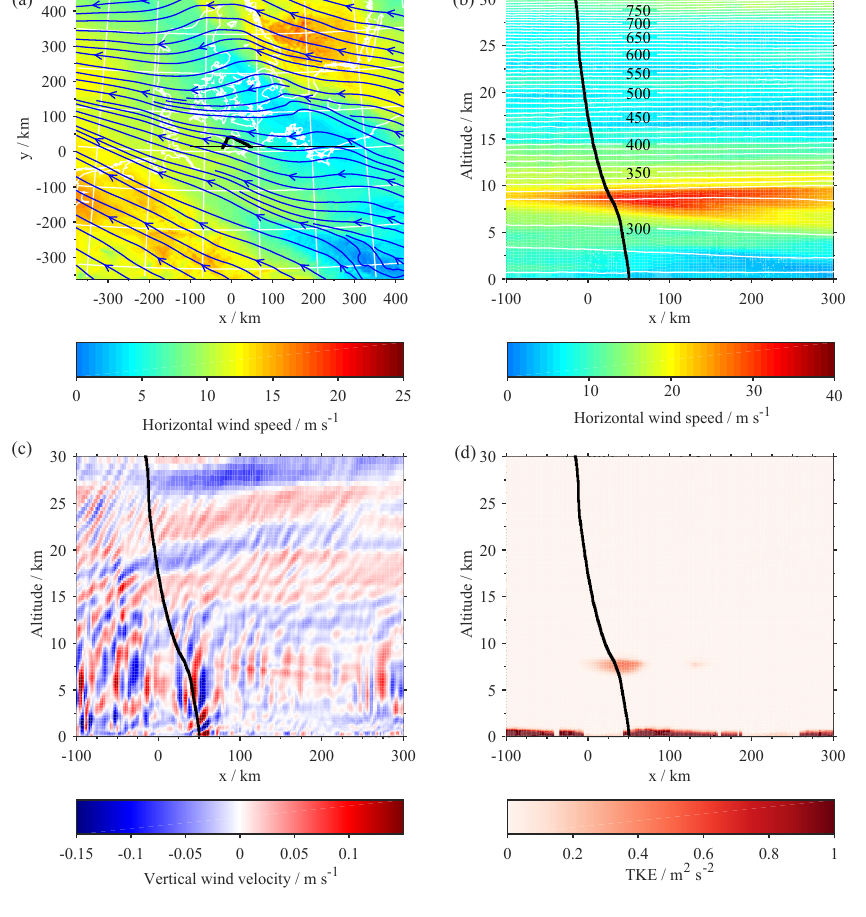
Figure 4. Same as Fig. 2, but for WRF simulations for 27 March 2014, 11:00UT.